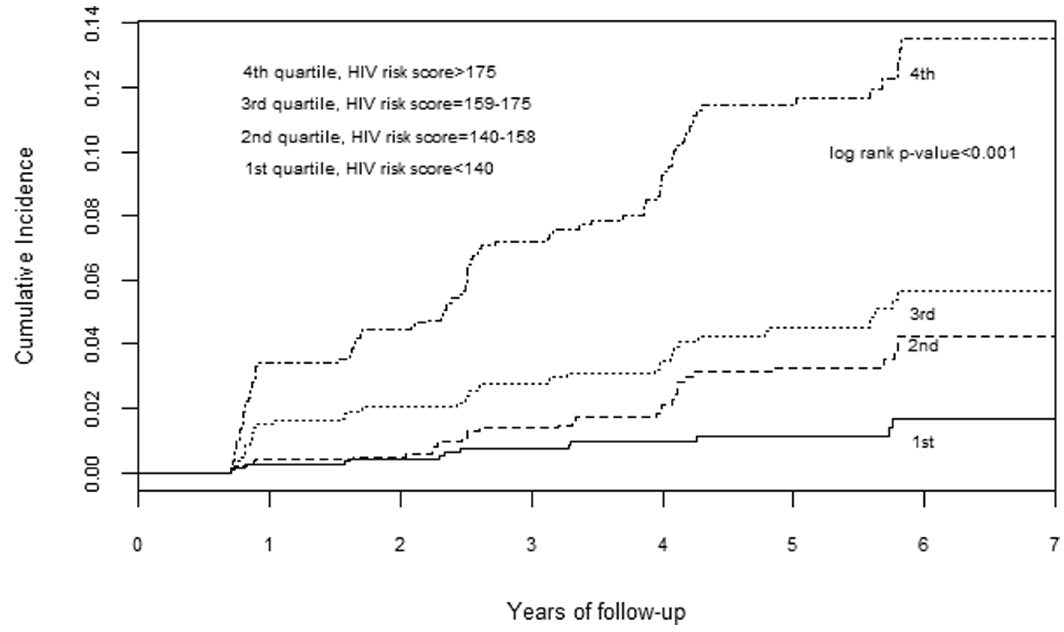
Figure 1. Cumulative HIV incidence by predicted quartile of HIV risk score for sexually active men.